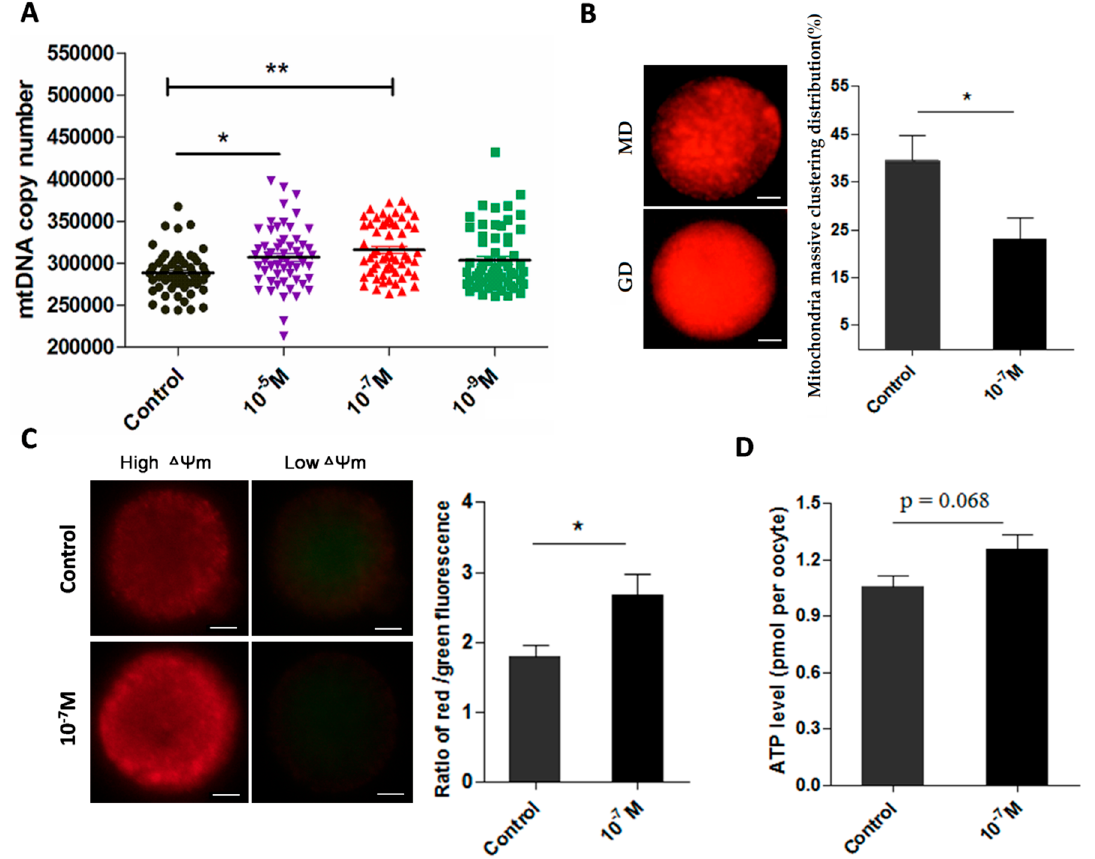
Figure 4. Effects of melatonin on mitochondria function and ATP production in MII-stage oocytes. ( A ) Cytoplasmic mtDNA copy number in MII-stage oocytes (mean ± SEM of 238 oocytes); ( B ) The state of mitochondria distribution (mean ± SEM of 178 oocytes), GD: granulated distribution; MD: massive clustering distribution. Scale bar = 20 μ m; ( C ) Mitochondria membrane potential in MII-stage oocytes (mean ± SEM of 72 oocytes), Scale bar = 20 μ m; ( D ) Cytoplasmic ATP levels in individual MII oocytes (mean ± SEM of 120 oocytes). “*” represent significant differences, p < 0.05; “**” represent significant differences, p < 0.01.